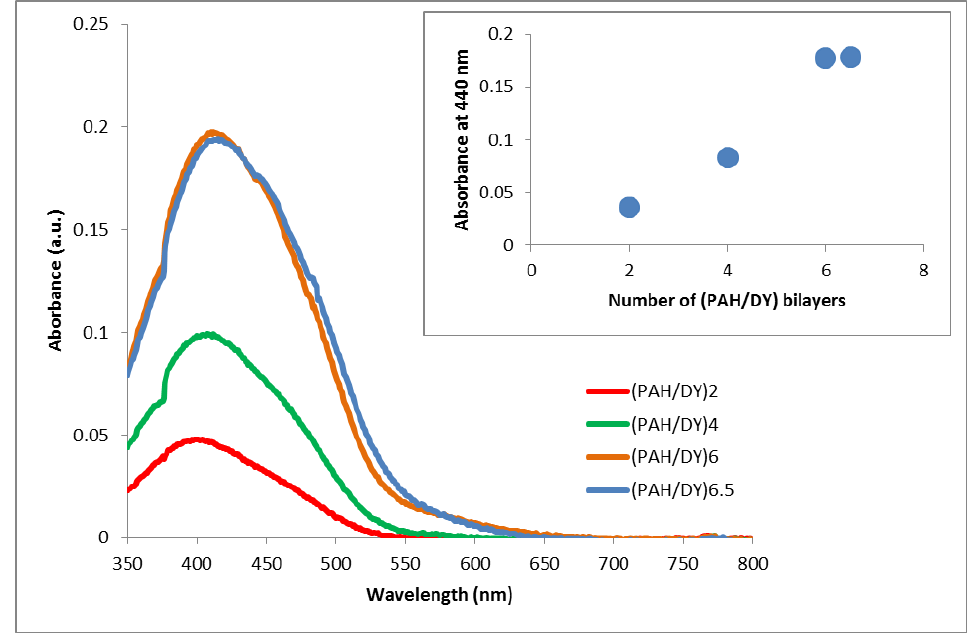
Figure 2. Absorbance spectra of various (PAH / DY) films. Inset shows absorbance versus number of bilayers.